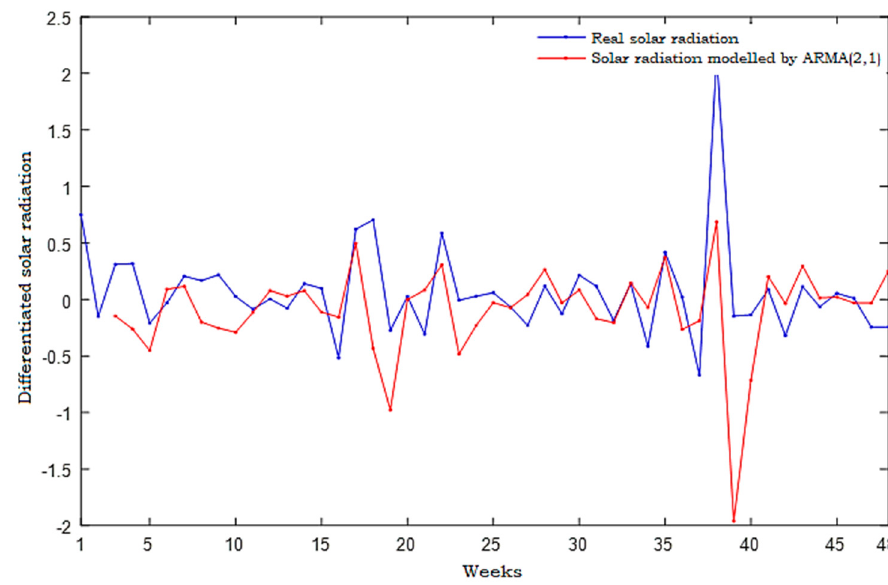
Figure 22. Relative differentiation of annual solar radiation.